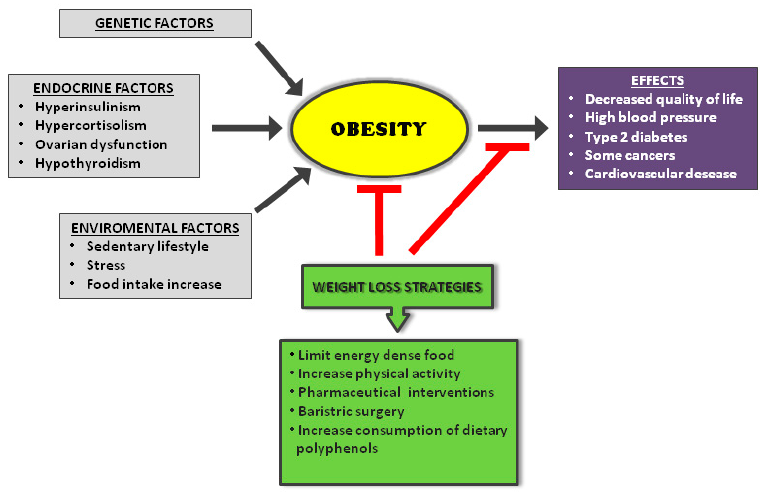
Figure 2. Causes and consequences of obesity with weight loss strategies.